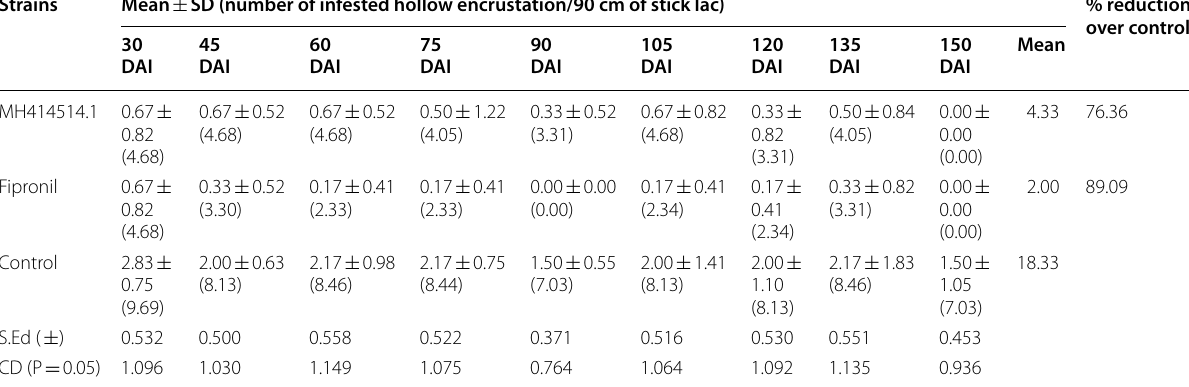
Data are mean of 7 replications. Data within the parentheses are angular transformed value DAI days after inoculation of broodlac